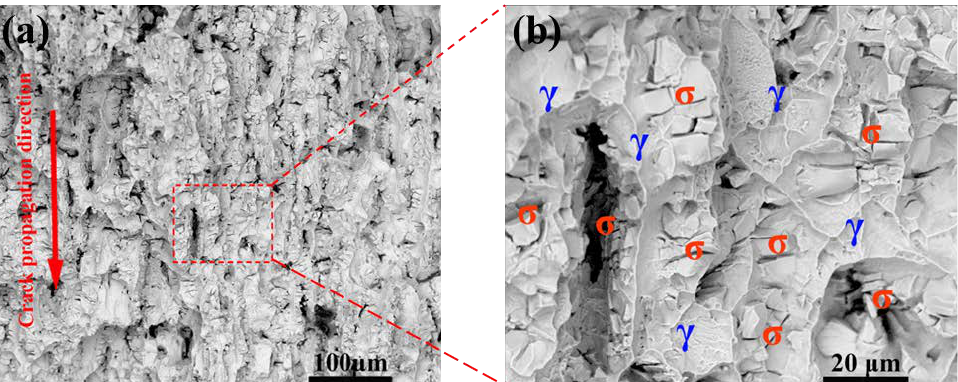
Figure 5. Fracture character of the impact test specimen tested at room temperature. ( a ) Fracture surface and ( b ) partial magnification.